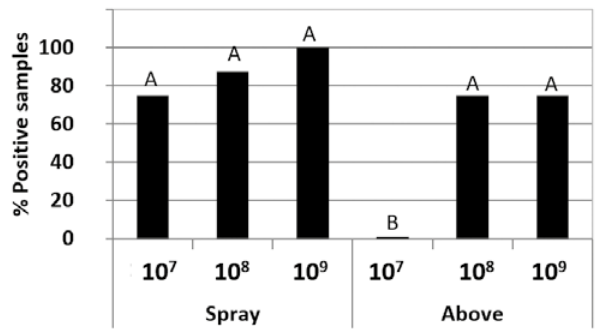
Figure 1. Mean proportions of grapevine tissue samples containing Frateuria defendens ( Frd ; determined by PCR) after spraying with various concentrations of bacterial suspension. Frd was monitored at and above spraying point of field grown grapevine plants 7 dpi (N = 8 per treatment, N = 6 per control). Since results showed sta- tistically significant interactions between main effects (cell concen- tration of the sprayed suspension and point of inoculation) each variable is presented separately. Different letters indicate significant differences between categories (α =